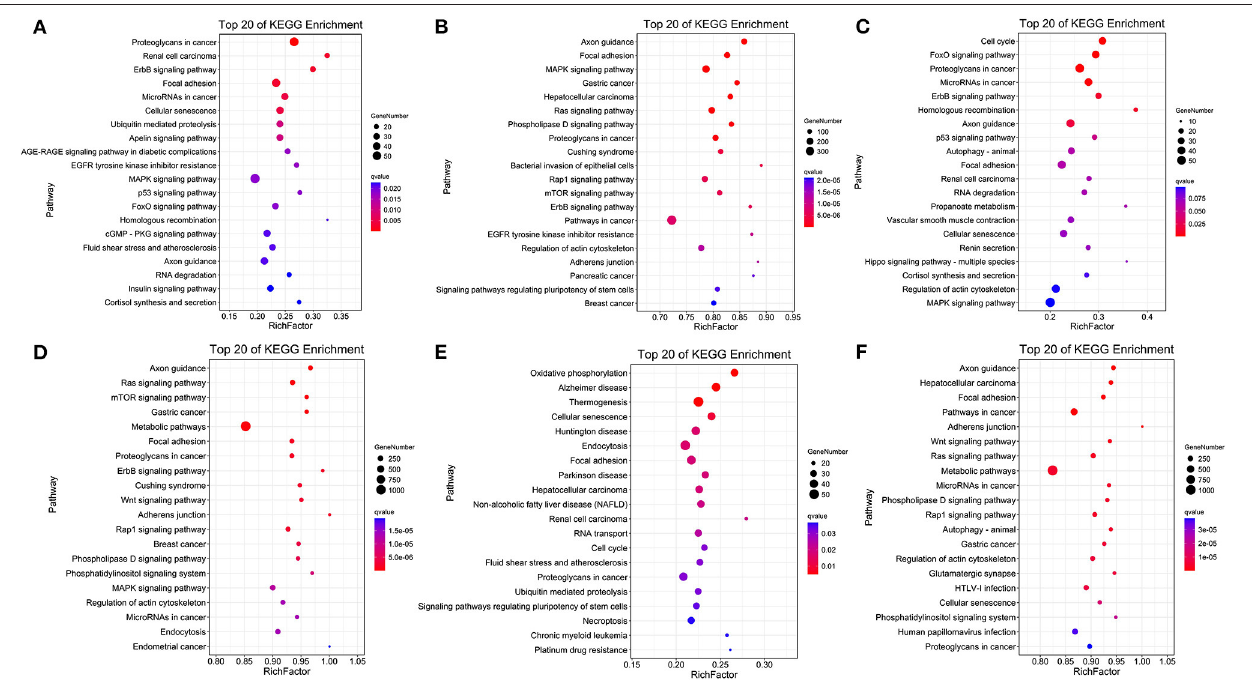
FIGURE 4 | KEGG pathway enrichment analysis. Common target mRNAs of DElncRNAs (A) and DEmiRNAs (B) between the normoxic (TN and LN) and hypoxic (TL and LL) groups. Target mRNAs of DElncRNAs (C) and DEmiRNAs (D) between the TN and TL groups. Target mRNAs of DElncRNAs (E) and DEmiRNA (F) between the LN and LL